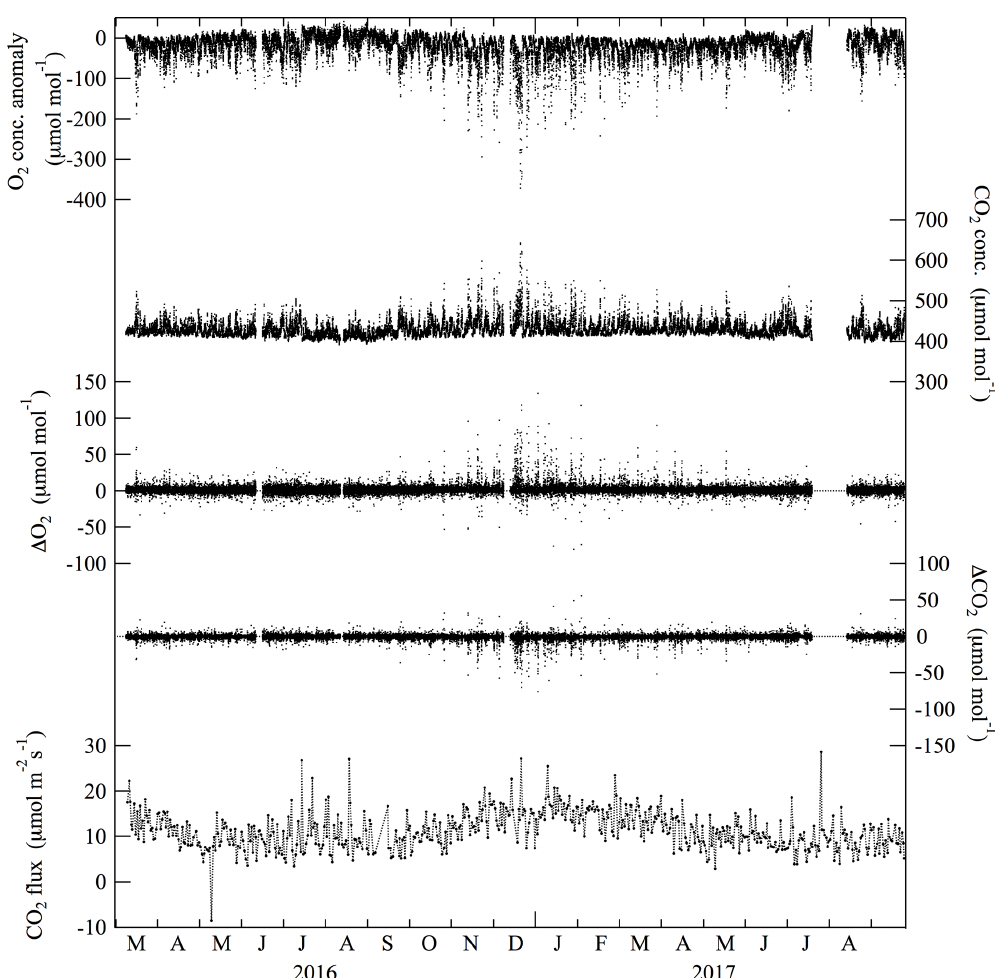
Figure 2. Variations in O 2 and CO 2 concentrations observed at the tower height of 52m at Yoyogi, Tokyo, Japan, for the period March 2016– September 2017. The O 2 concentrations are expressed as deviations from the value observed at 09:58 local time on 9 March 2016. (cid:49) O 2 , representing the differences calculated by subtracting the observed O 2 concentrations at 37m from that at 52m, are also shown. (cid:49) CO 2 are the same as (cid:49) O 2 but for CO 2 concentration. Daily mean CO 2 fluxes observed using the eddy correlation method are also shown, and the flux takes on a positive value when the urban area emits CO 2 to the overlaying